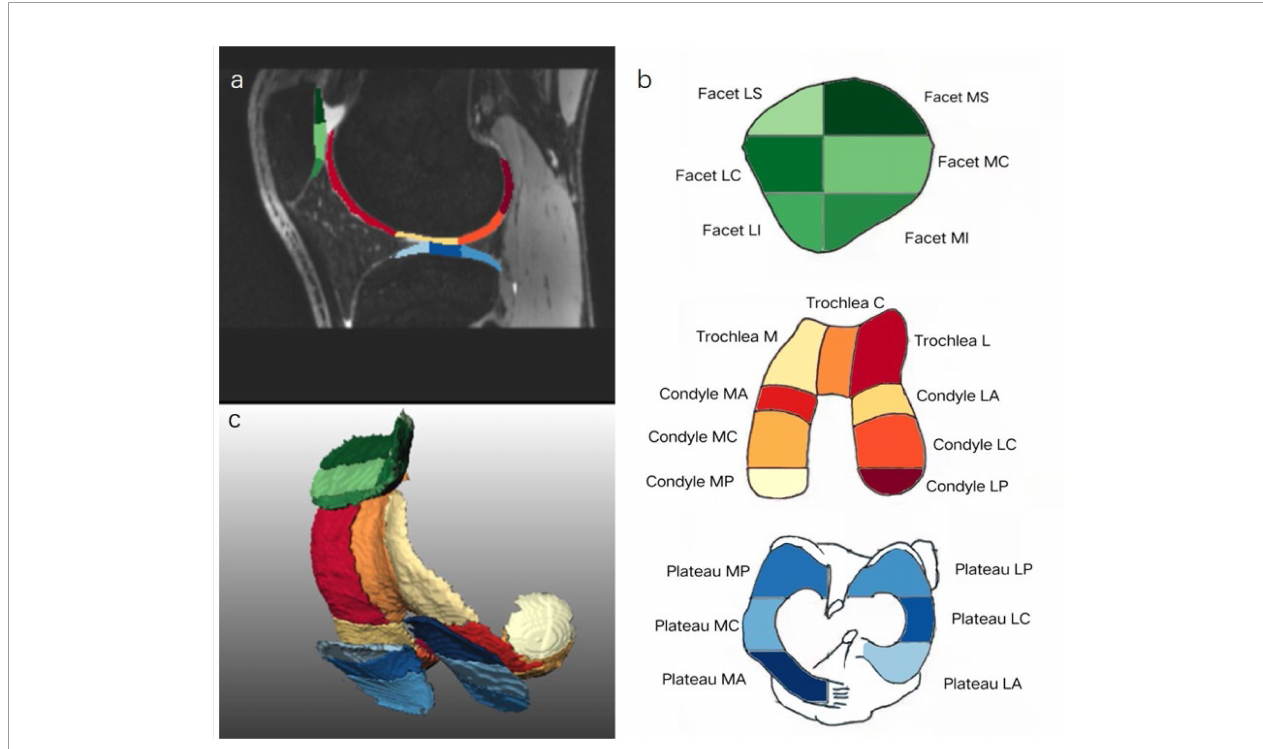
FIGURE 2 | Automatic cartilage segmentation of the knee 21 cartilage sub-regions on sagittal 3D-DESSwe (A) , schematic diagram with colors (B) and 3D reconstruction image (C) . Green (dark green, light green) represents patellar cartilage; warm colors (red, orange, etc.) represent femoral cartilage; cold colors (light blue, dark blue, etc.) represent tibial cartilage.